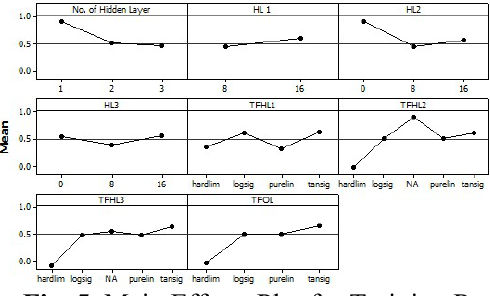
Fig. 5. Main Effects Plot for Training R Fig. 6. Main Effects Plot for Validation Perfor-